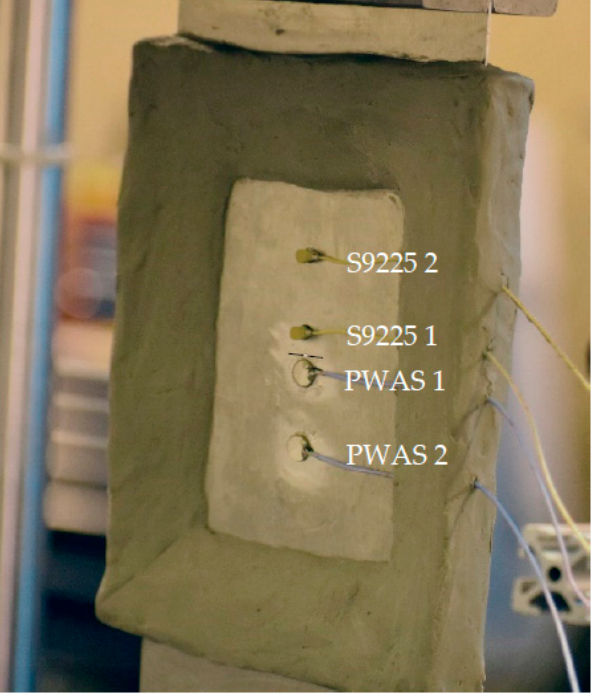
Figure 1. AE test specimen bonded with the two-PWAS and two-S9225 sensors. Non-reflective clay boundaries (NRB) were provided on the specimen to avoid the reflection of AE signals from the specimen boundaries.